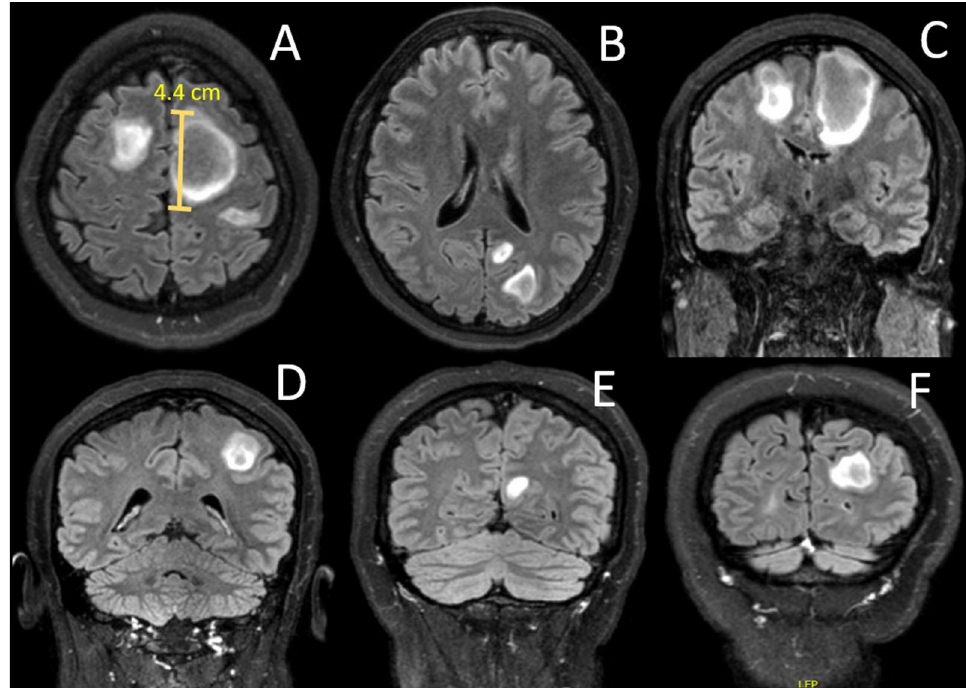
Fig. 1 Axial T2 fluid-attenuated inversion recovery (T2 FLAIR) MRIs at admission showing five large juxtacortical lesions supratentorially. One lesion in the right cerebral hemisphere and four in the left cerebral hemisphere. The largest lesion was located in the left frontal lope and measured